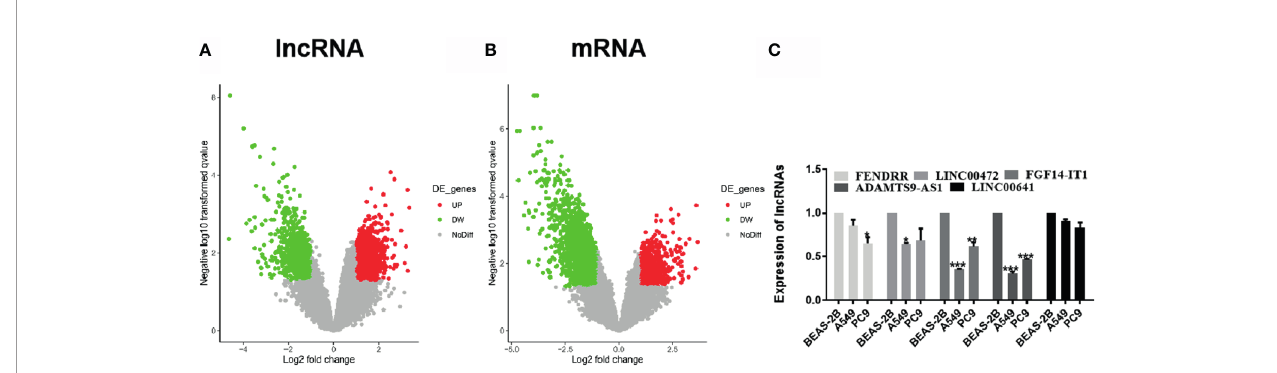
FIGURE 1 | Differentially expressed of lncRNAs and mRNAs were identi fi ed. (A) Approximately 2,649 differentially expressed lncRNAs were screened, of which 1,660 ascended and 989 descended. (B) Approximately 4,303 differentially expressed mRNAs were screened, of which 1,128 ascended and 3,175 descended. (C) The fi ve lncRNAs with the signi fi cant downregulation were selected for expression veri fi cation in LUAD cell lines and human normal lung epithelial cells. *p < 0.05; **p < 0.01; ***p < 0.001. LUAD, lung adenocarcinoma; lncRNA, Long non-coding